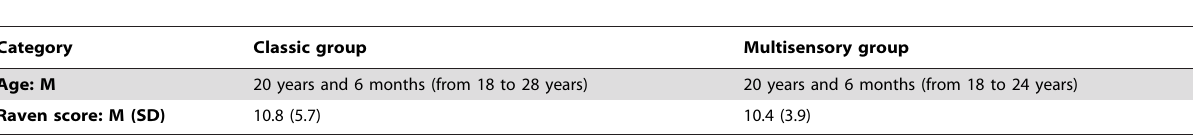
Table 1. Characteristics of participants in each training